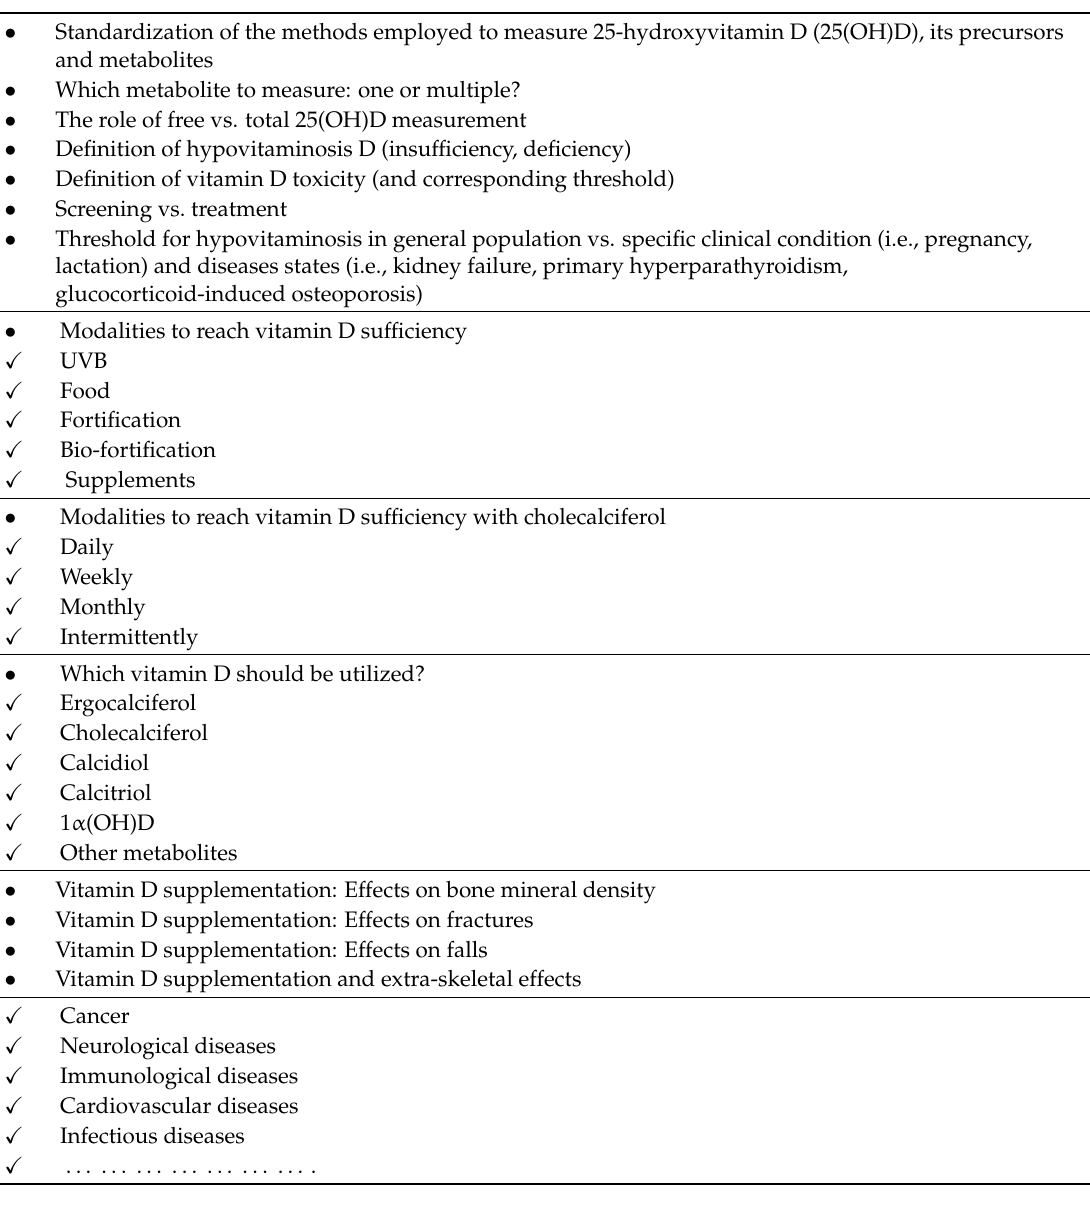
Table 1. Most important (and unsolved) controversies surrounding Vitamin